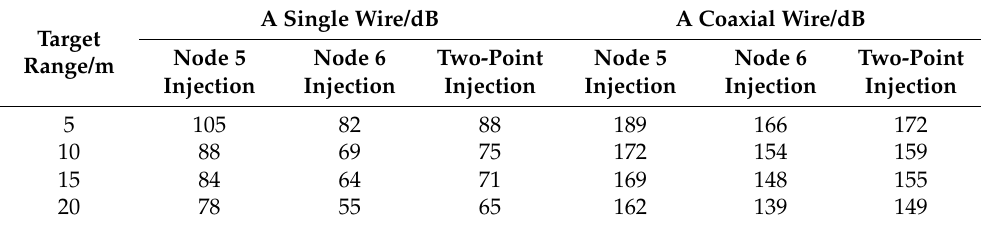
Table 5. Minimum amplification of EMI sources.